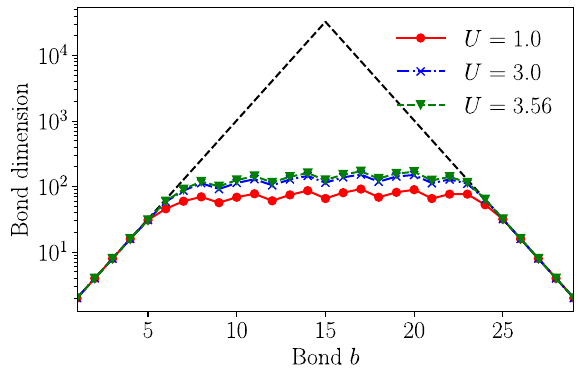
FIG. 16. Bond dimensions of MPSs representing the vertex function Γ with cutoff ϵ ¼ 10 − 14 . The dashed line indicates the d maximum bond dimensions in maximally entangled cases.